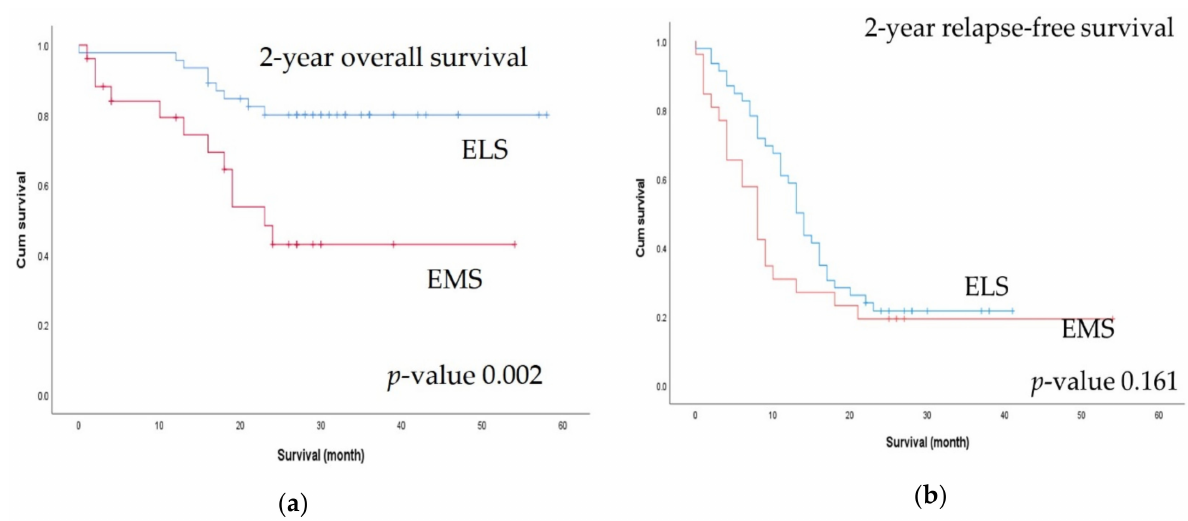
Figure 2. Comparison of 2-year survival outcomes between the elective surgery (ELS) and emergency